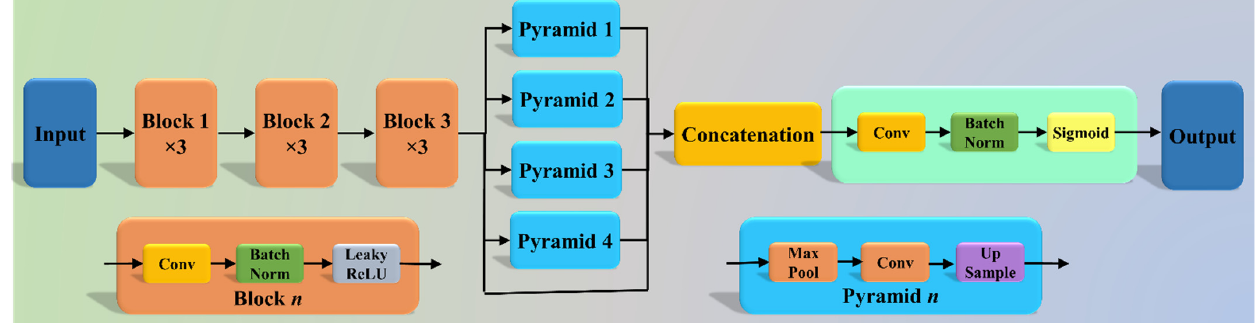
Figure 4. PSP Net architecture.